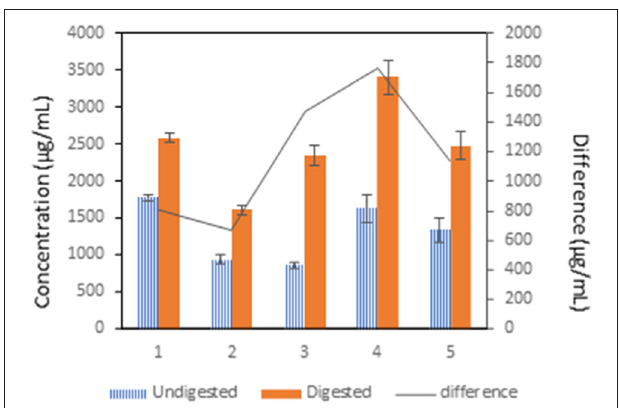
FIGURE 1 | The influence of treatment of pea flour [(1): untreated flour, (2): cooked at 100 ◦ C for 10min, (3): cooked at 100 ◦ C for 120min, (4): fermented flour without cooking, (5): fermented flour cooked at 100 ◦ C for 120min.] on protein digestion. The difference was calculated after subtraction of the concentration of the undigested sample from the digested